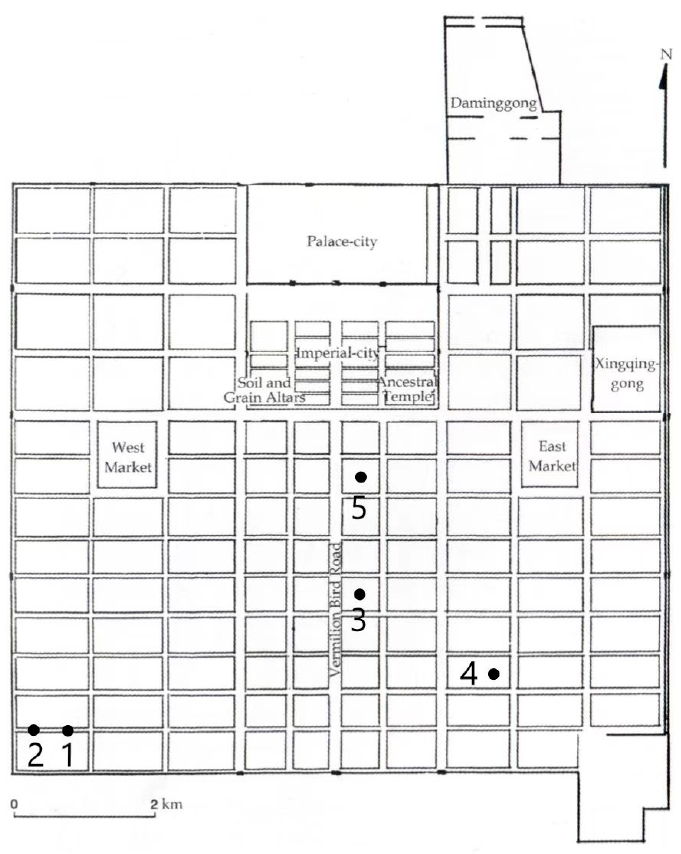
Figure 4. The locations of the main imperial monasteries in the plan of Sui-Tang Daxing-Chang’an, 581–907. 19 1—Da Zhuangyan Monastery; 2—Da Zongchi Monastery; 3—Da Xingshan Monastery; 4—Da Ci’en Monastery; 5—Da Jianfu Monastery.